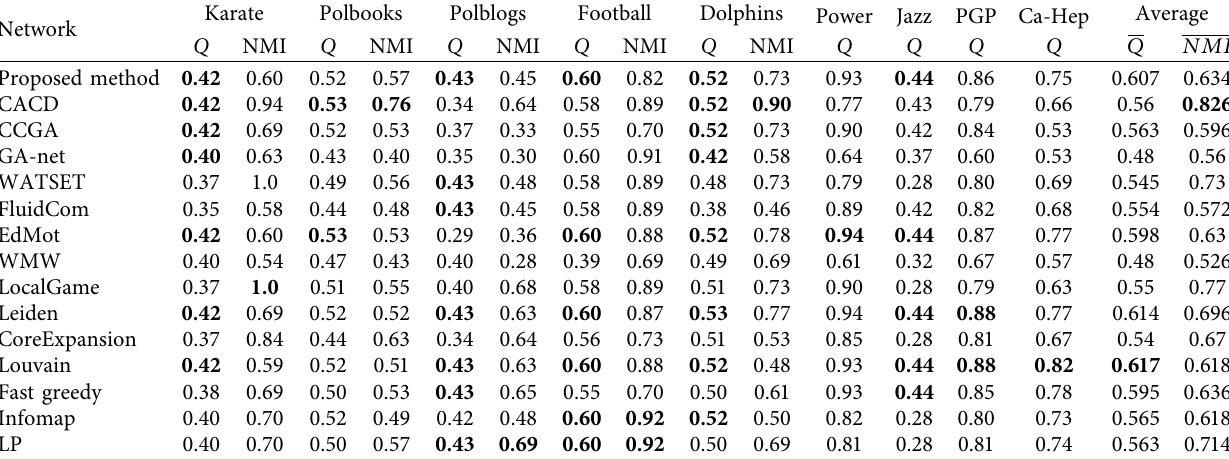
Figure 11: Comparison of variations of the generation count and modularity for 3 diferent mutation functions. 100 experiments were performed over the Jazz dataset for each function, while the stopping criteria was, exceeding the modularity of 0.435, or seeing no improvement on the maximum modularity of each generation on 50 respective generations. (a) Box plots of the number of generations and (b) box plots of the maximum modularity of each experiment. Table 4: Comparison of the results of real-world datasets of the proposed method with other methods based on NMI and modularity ( Q ) measures.